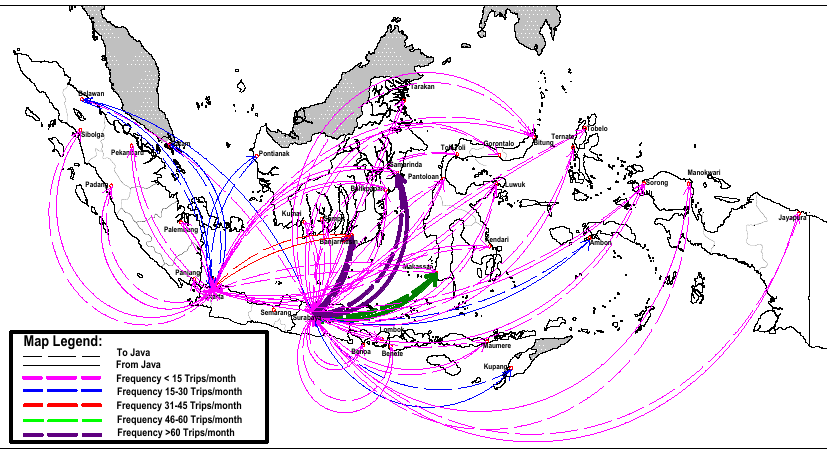
Figure 1: Domestic Shipping